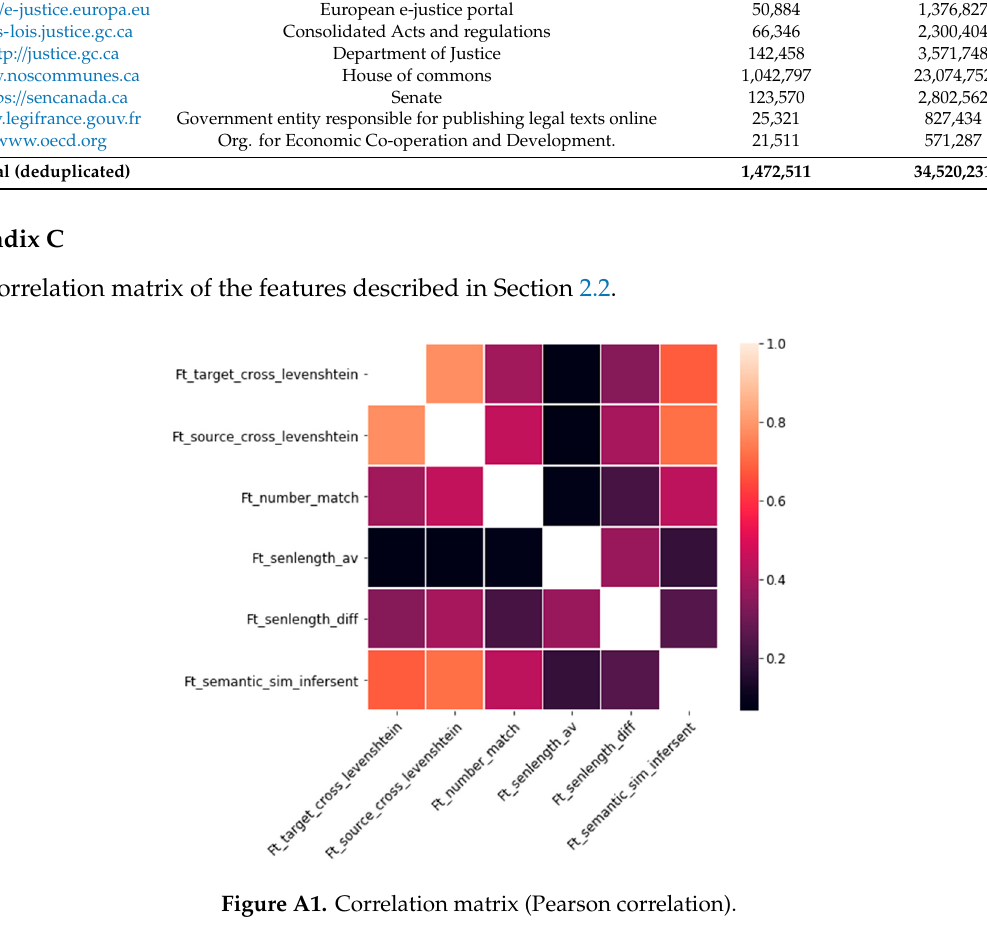
Table A2. Overview of the scraped corpus EN–FR on domain / url-level.